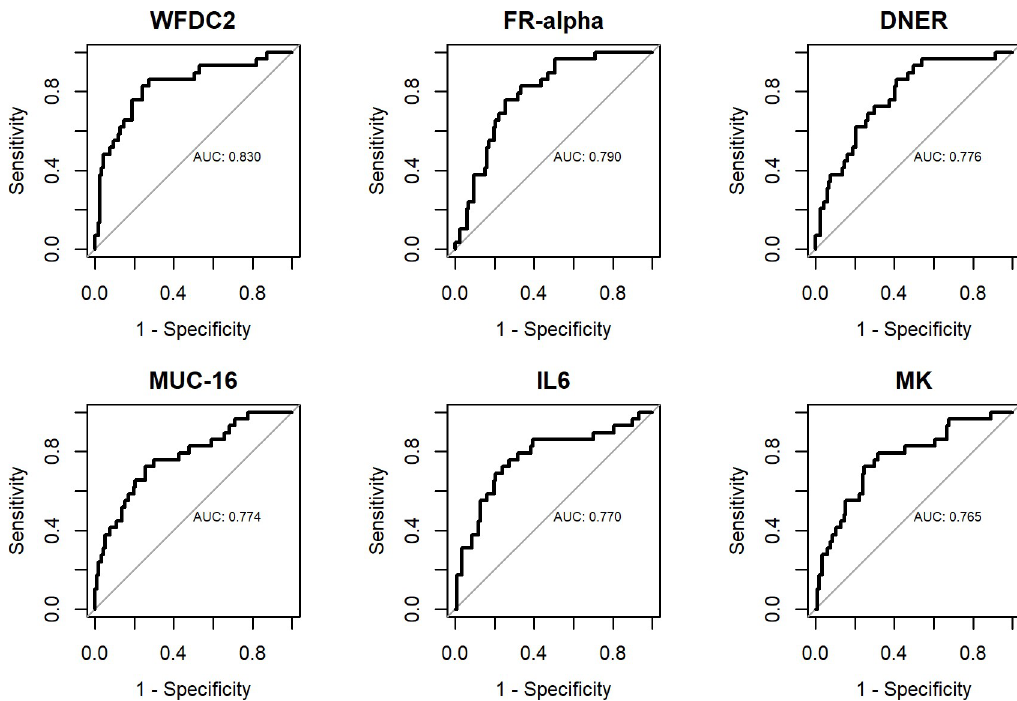
Fig 1. ROC curves for individual biomarkers. Benign tumors vs.